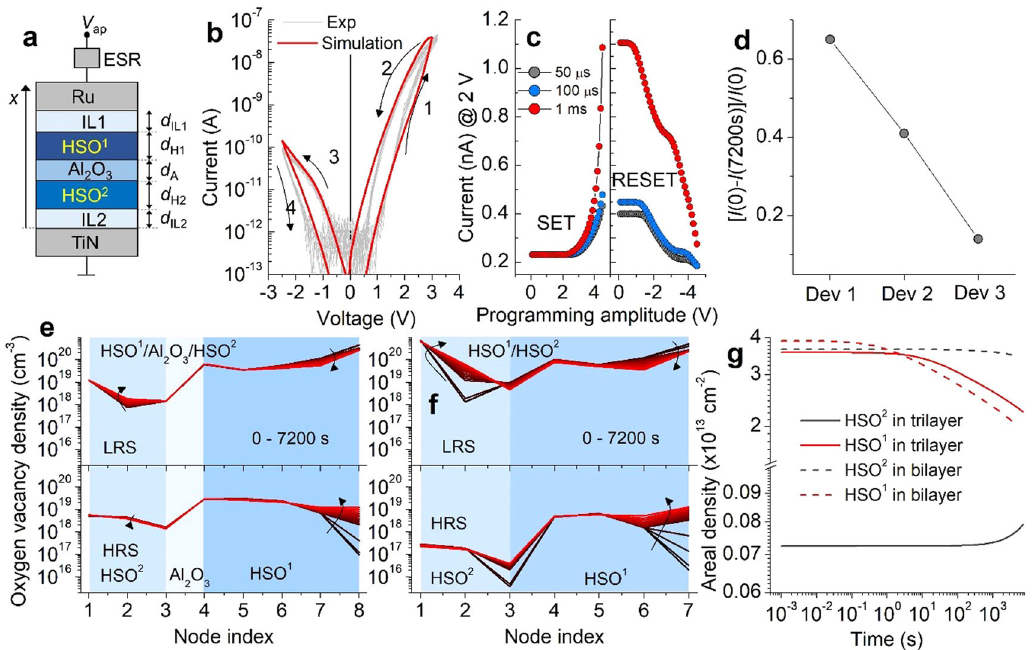
Fig. 4 Resistive switching simulation. a One-dimensional con fi guration of the SRMC for simulation. b Simulated I – V loop (quasi-static behavior) in comparison with experimental data. c Simulated switching behaviors in response to voltage pulses of different widths and amplitudes. d Simulated LRS retention for the HSO 2 -only cell (Dev 1), HSO 1 /HSO 2 cell (Dev 2), and HSO 1 /Al 2 O 3 /HSO 2 SRMC (Dev 3). e , f Simulated oxygen vacancy distributions in the trilayer SRMC and HSO 1 /HSO 2 cell in the LRS (upper panel) and HRS (lower panel). The change of the distribution in each state was monitored in the time range (0 – 7200 s). g Retention of areal density of oxygen vacancies in the LRS in each layer of the trilayer and bilayer